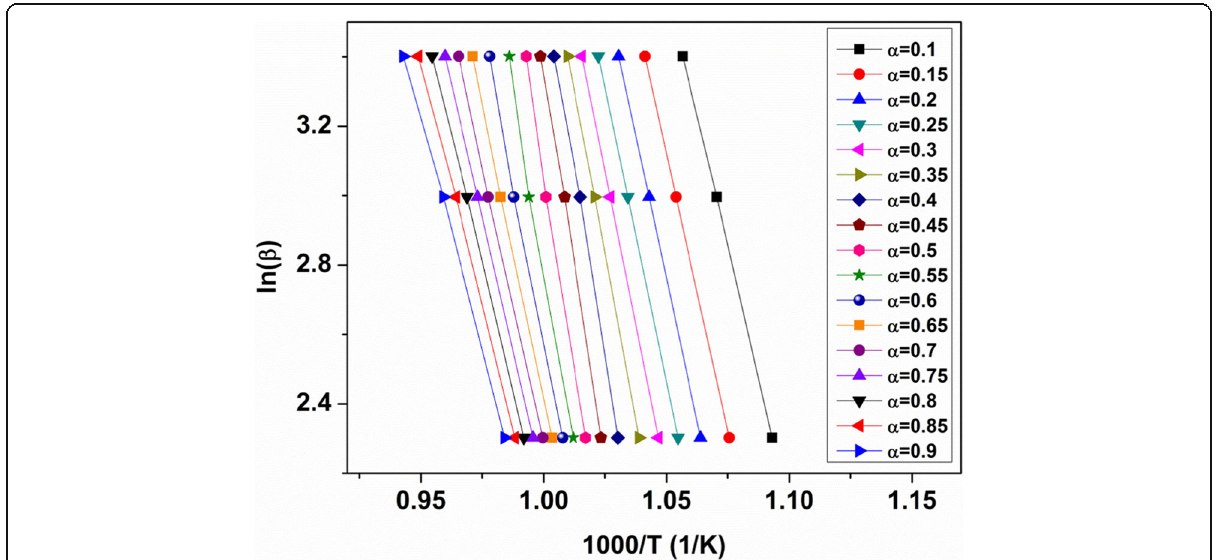
Fig. 5 FWO plot of the solid-state reaction for different values of